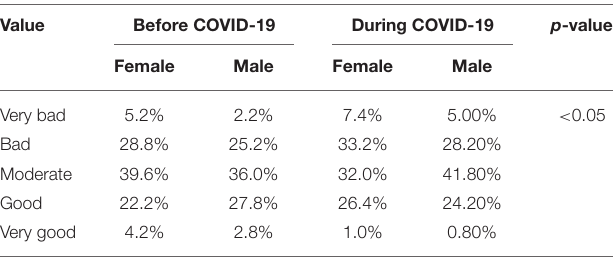
TABLE 1 | Self-assessment of health condition in the study group (according to WHOQOL)— N = 450.